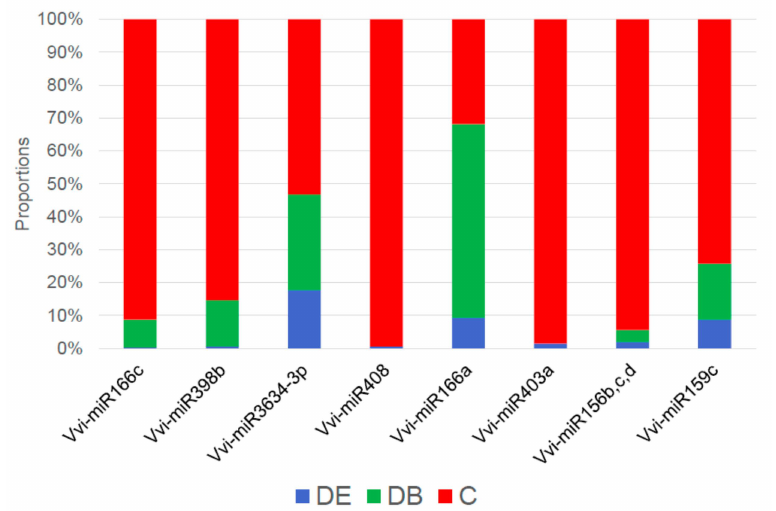
Figure 5. Bar plot depicting the proportions of treatments across known detected grapevine matured miRNAs, CLC Genomics Workbench, miRBase Release 22.1. Proportions were calculated based on normalized total reads.